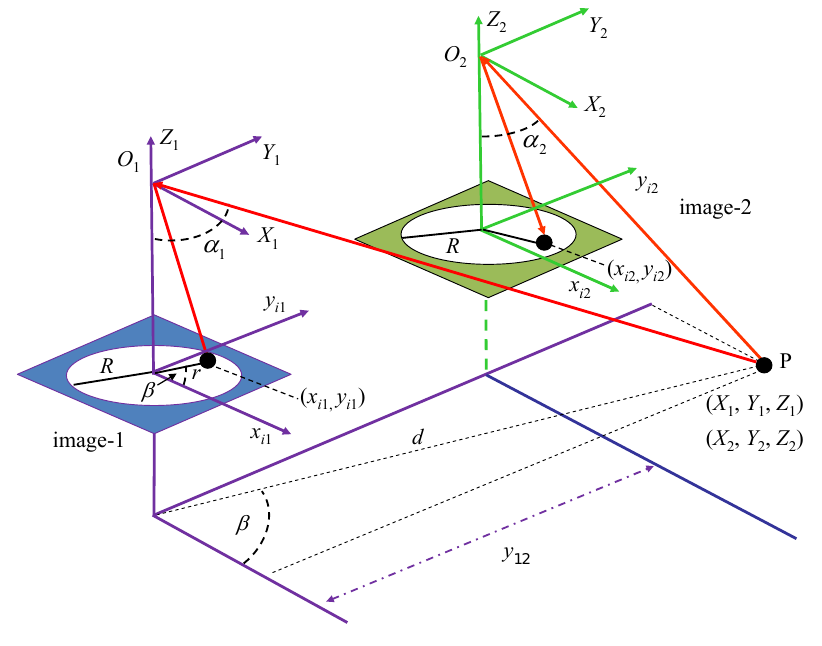
Figure 3. Geometric projections and relations for the fish-eye based stereo vision